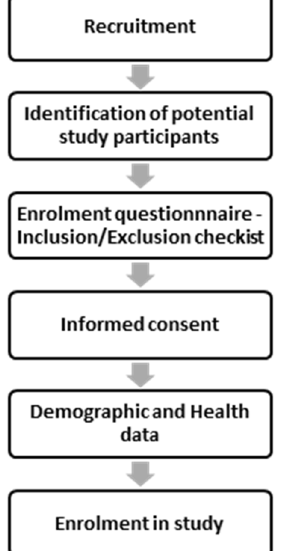
Figure 2. Recruitment and enrolment workflow .